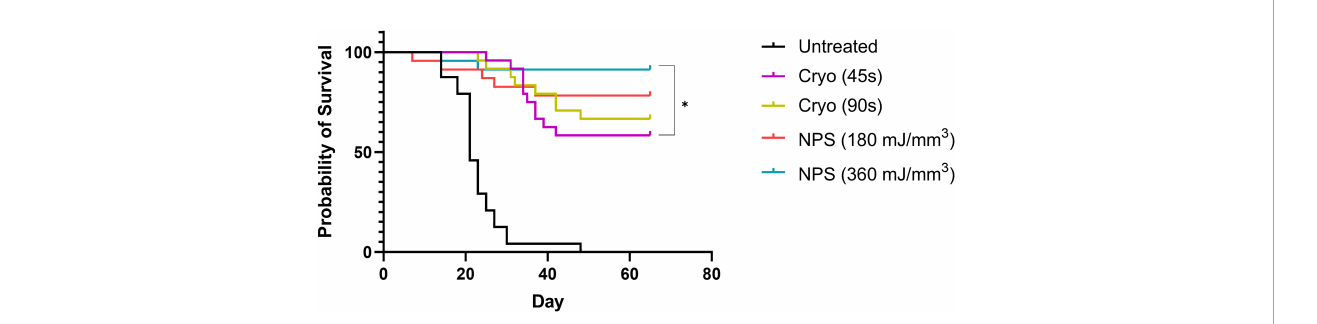
FIGURE 4 Kaplan-Meier Survival data to day 65 for each treatment. The high dose NPS group survival is signi fi cantly better than the 45s cryo treatment group. Both treatment does of NPS had higher rates of survival than either cryo group (log-Rank Mantel-Cox test, *p<0.05).